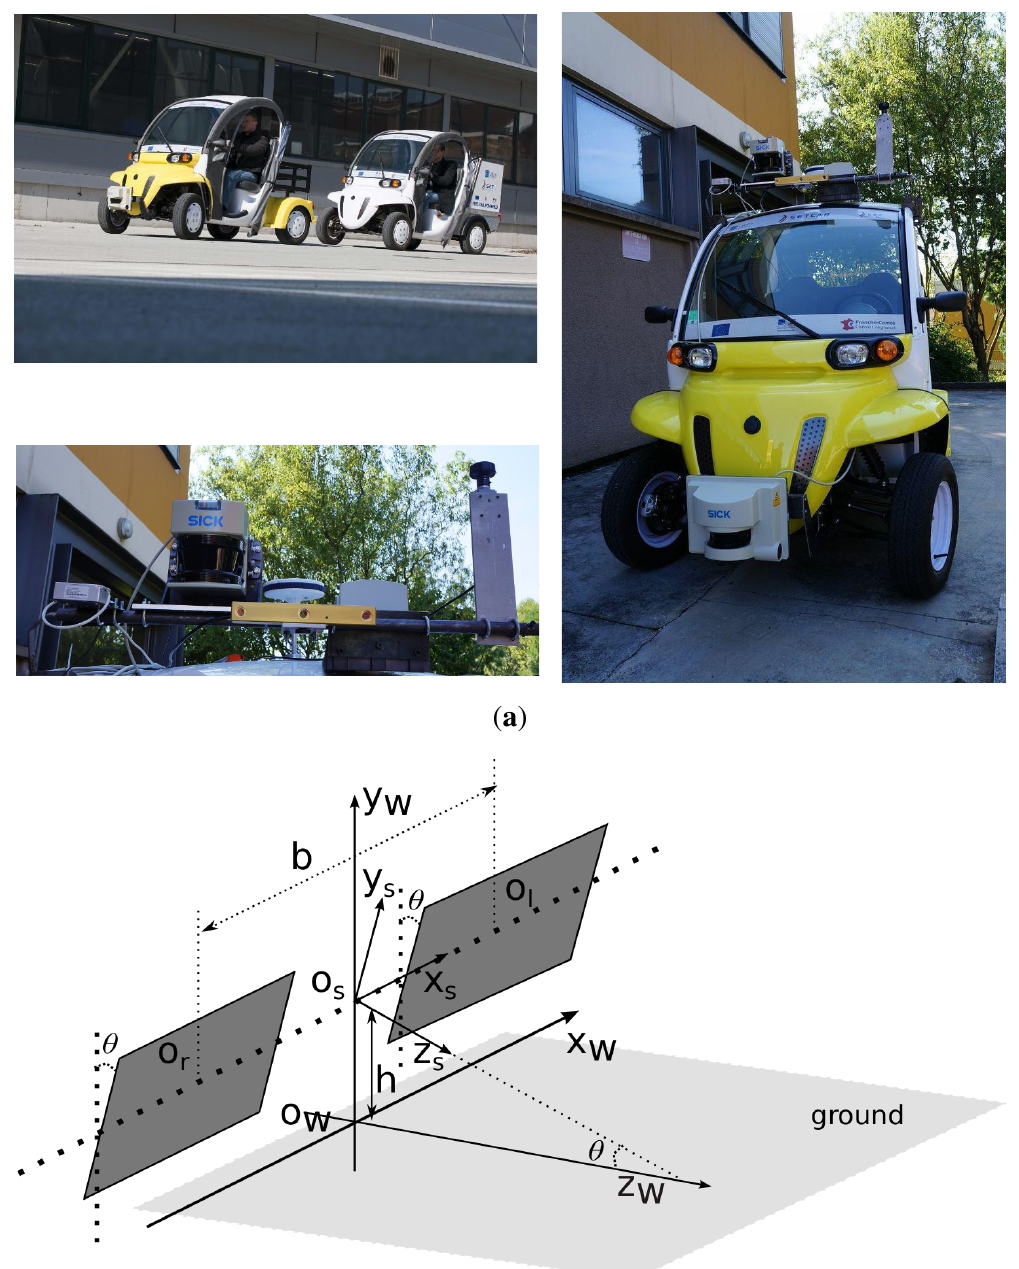
Figure 2. The platform and geometric model. ( a ) Our platform, SetCar, and the equipped sensors; ( b ) geometric model of the stereo vision